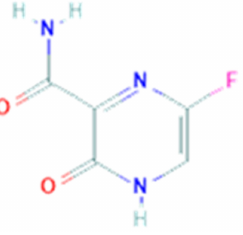
Figure 5. Chemical structure of favipiravir.